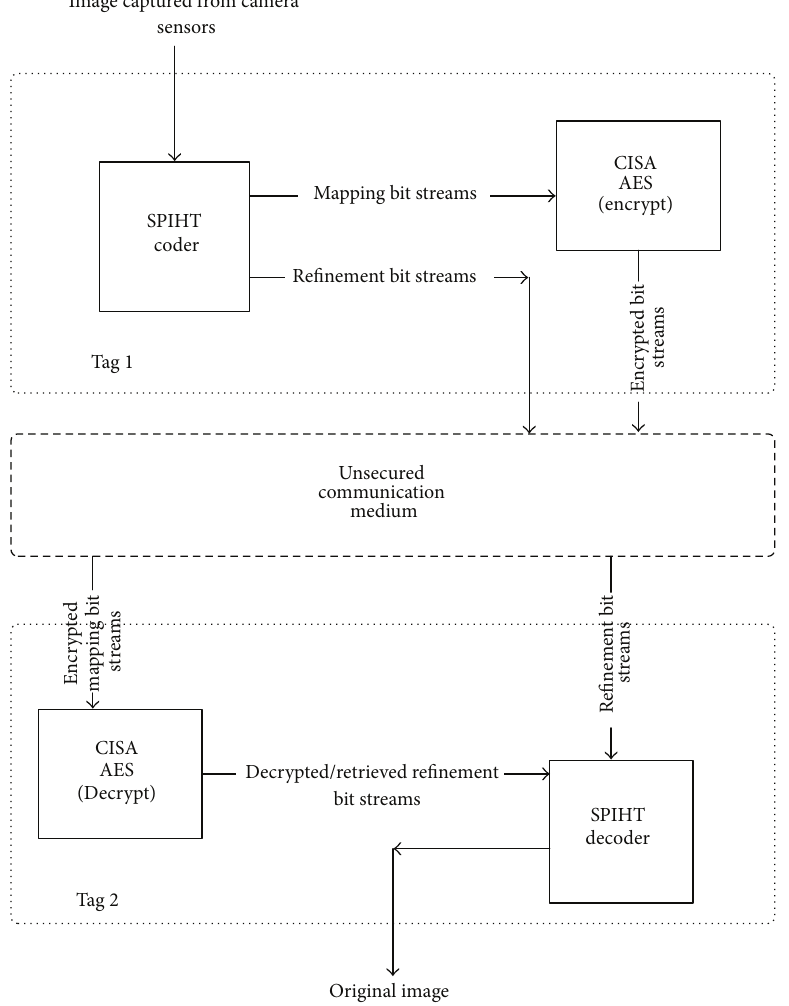
Figure 23: The illustration of the combined system of a SPIHT coder and an AES-based CISA to achieve the selective encryption.